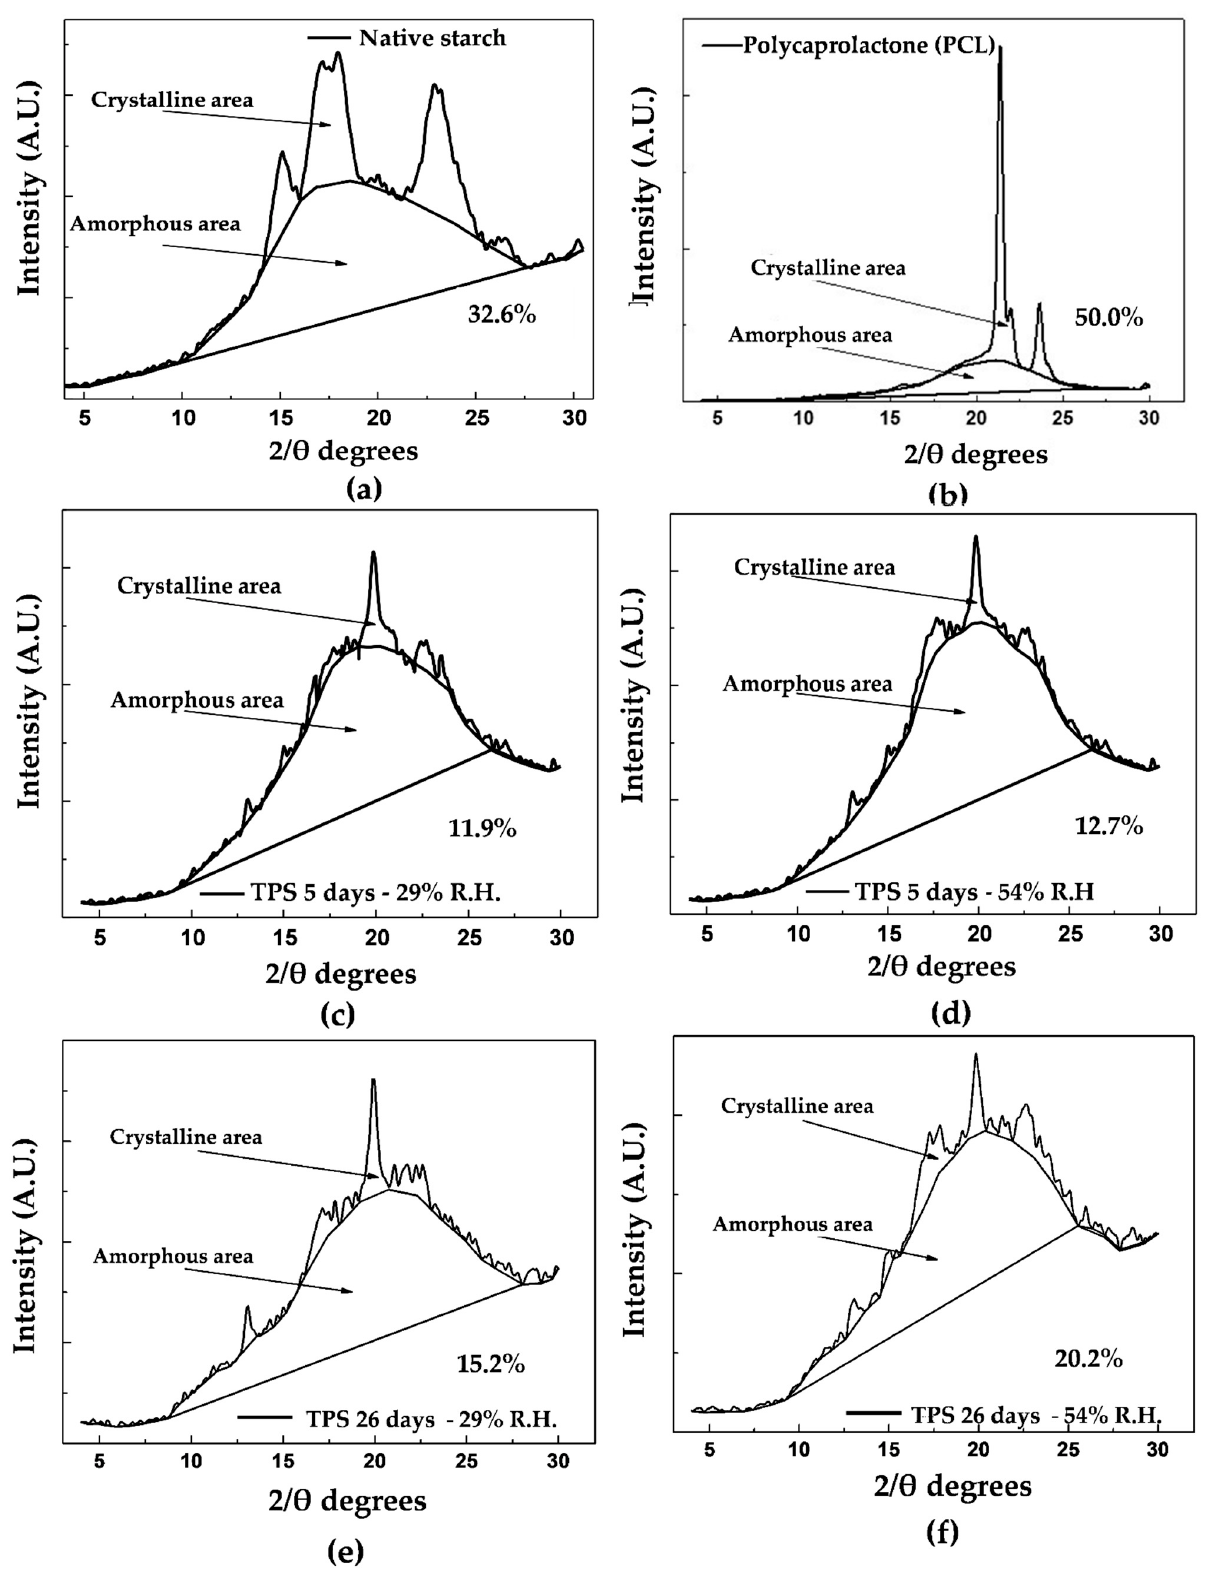
Figure 7. Crystalline and amorphous areas of ( a ) native starch, ( b ) PCL, ( c ) TPS at 5 days of storage and 29% relative humidity, ( d ) TPS at 5 days of storage and 54% relative humidity, ( e ) TPS at 26 days of storage and 29% relative humidity, ( f ) TPS at 26 days of storage and 54% relative humidity.